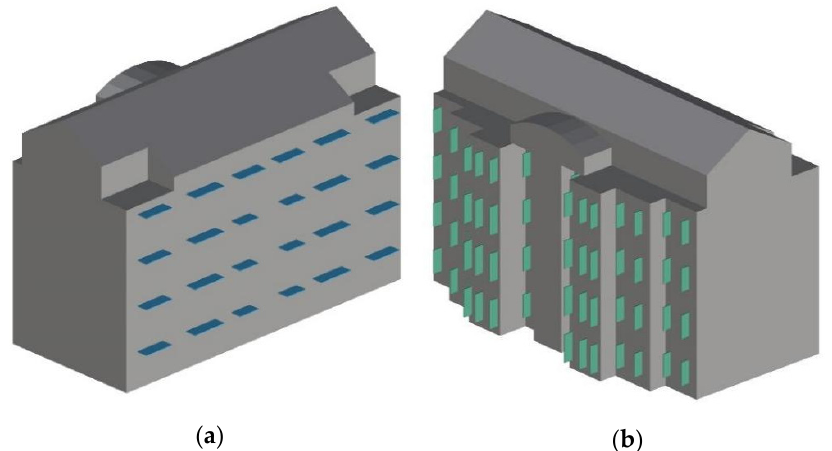
Figure 3. Schematic diagram of building model with sun visors. ( a ) Schematic diagram of the south-facing horizontal sun visors; ( b ) Schematic diagram of the north-facing horizontal sun visors.